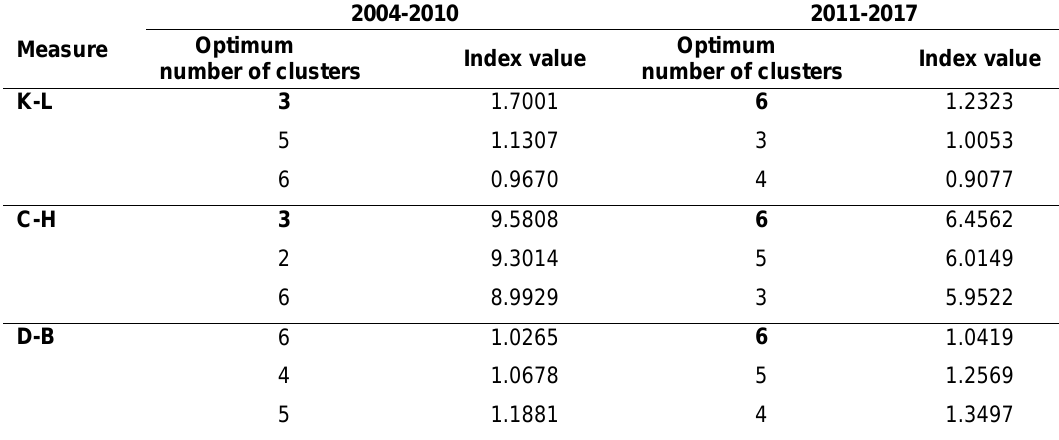
Table 1. Cluster validity